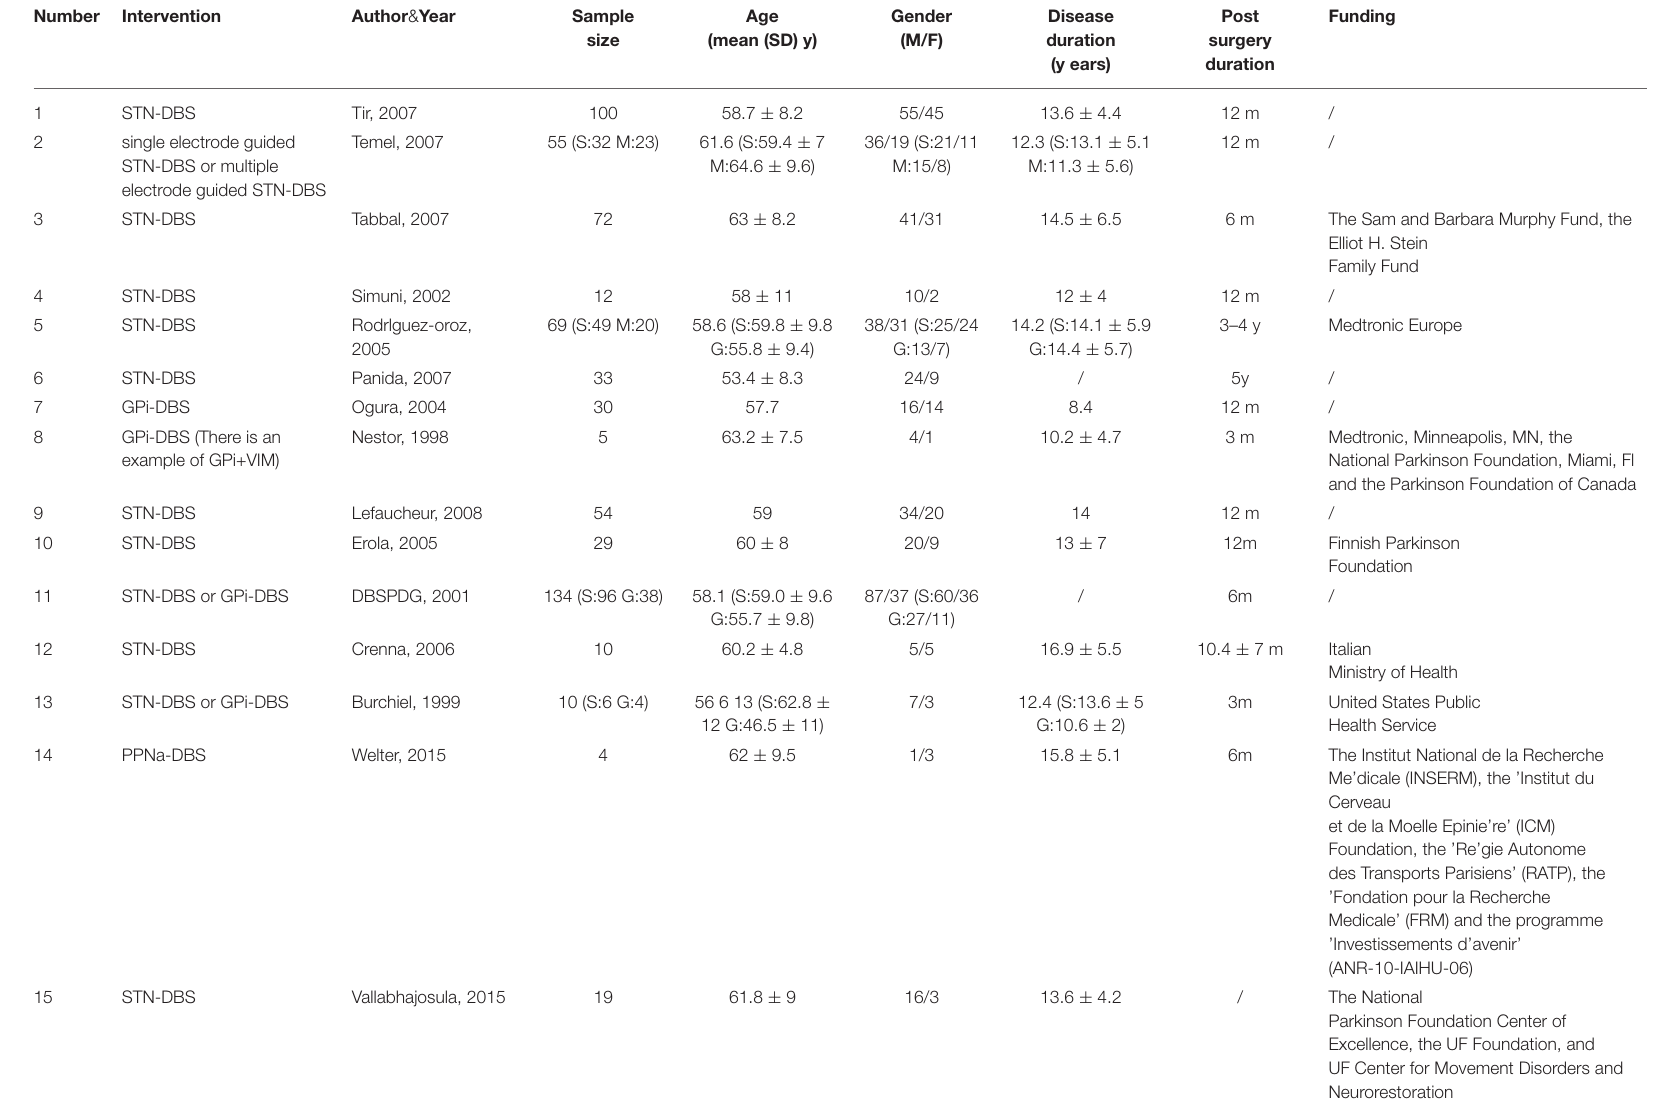
TABLE 1 | Characteristics of included